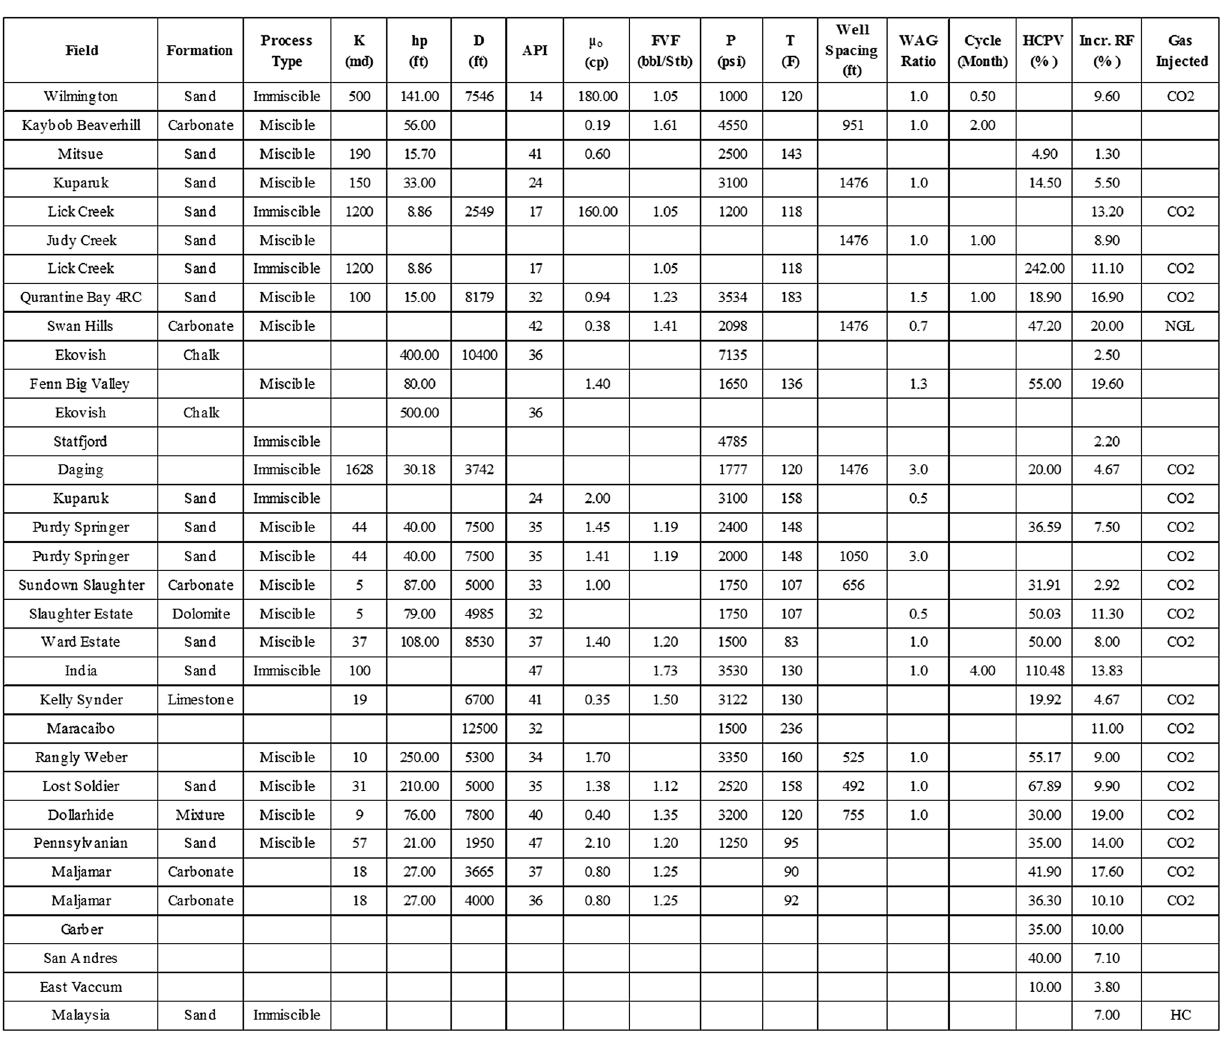
Fig. 3 WAG pilot data used in this research study